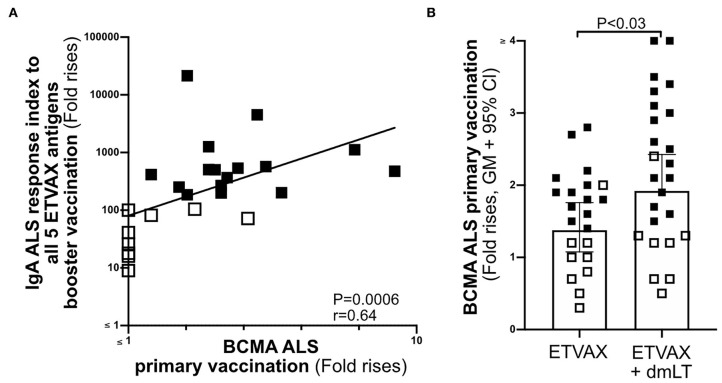
The usefulness of ALS BCMA as an oral vaccination biomarker. (A) Correlation between magnitudes of ALS BCMA responses following primary ETVAX vaccination and the combined booster ALS IgA responses to all five major ETVAX vaccine antigens (n = 29). (B) Magnitudes of ALS BCMA responses in volunteers who received ETVAX with 10 μg dmLT (n = 24) compared to ETVAX only (n = 21). Bars represent geometric means with 95% CI. Filled squares represent vaccine responders with an ALS IgA combined response index >150. Open squares represent vaccine responders with an ALS IgA combined response index <135.